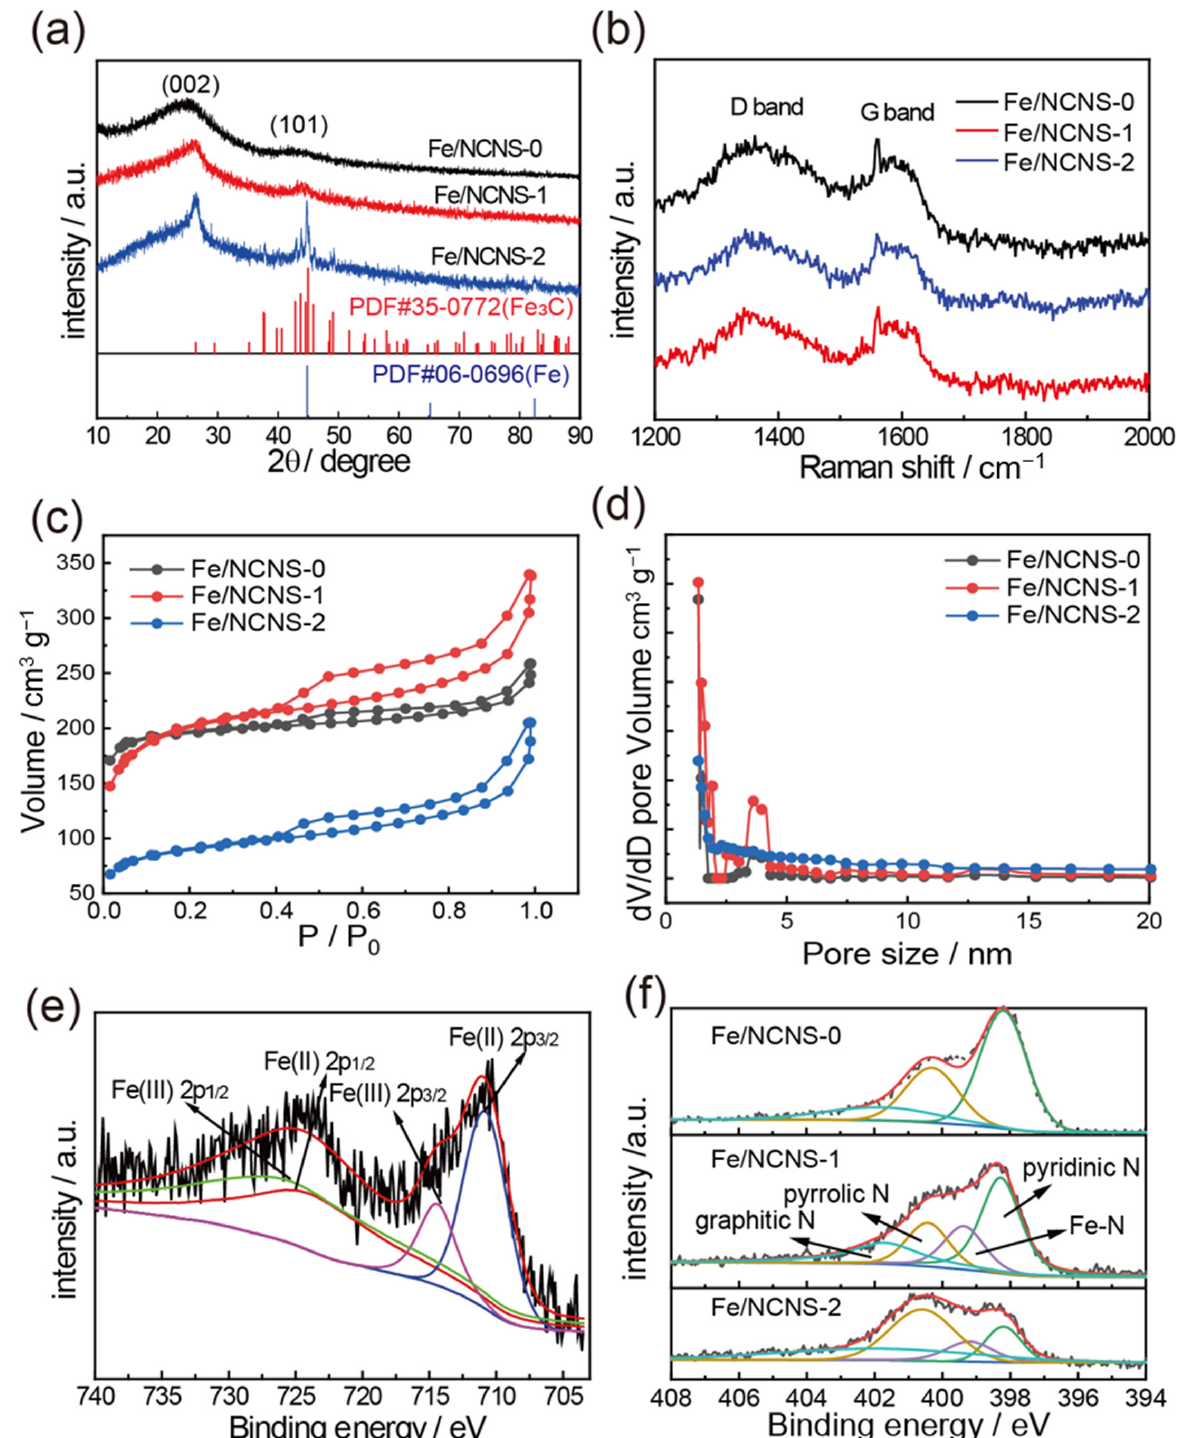
Figure 2. ( a ) XRD patterns, ( b ) Raman spectrum spectra ( c ) N 2 adsorption-desorption isotherms, ( d ) pore size distribution of Fe/NCNS-0, Fe/NCNS-1 and Fe/NCNS-2, ( e ) Fe 2p spectra of Fe/NCNS-1, ( f ) N 1s spectra of Fe/NCNS-0, Fe/NCNS-1 and Fe/NCNS-2.